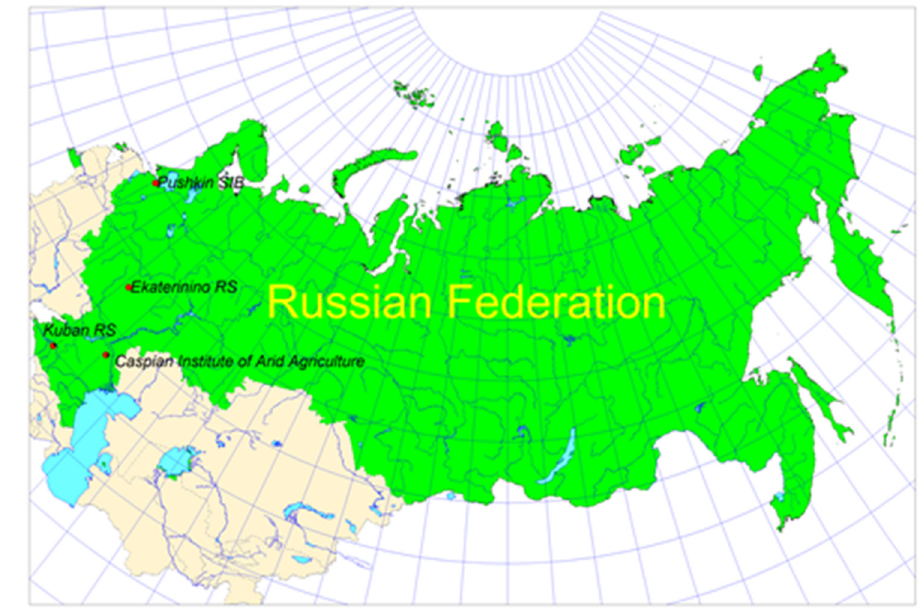
Figure 1. Location map of points of study of the ginger collection. RS—Research Station, SIB—Scientific industrial base. The most arid and hot climatic conditions in all the years of study were observed on Caspian I of AA in Astrakhan region, wet and cool on the Pushkin SIB in Leningrad region. Weather conditions in 2007 on Ekaterinino RS in Tambov region are close to